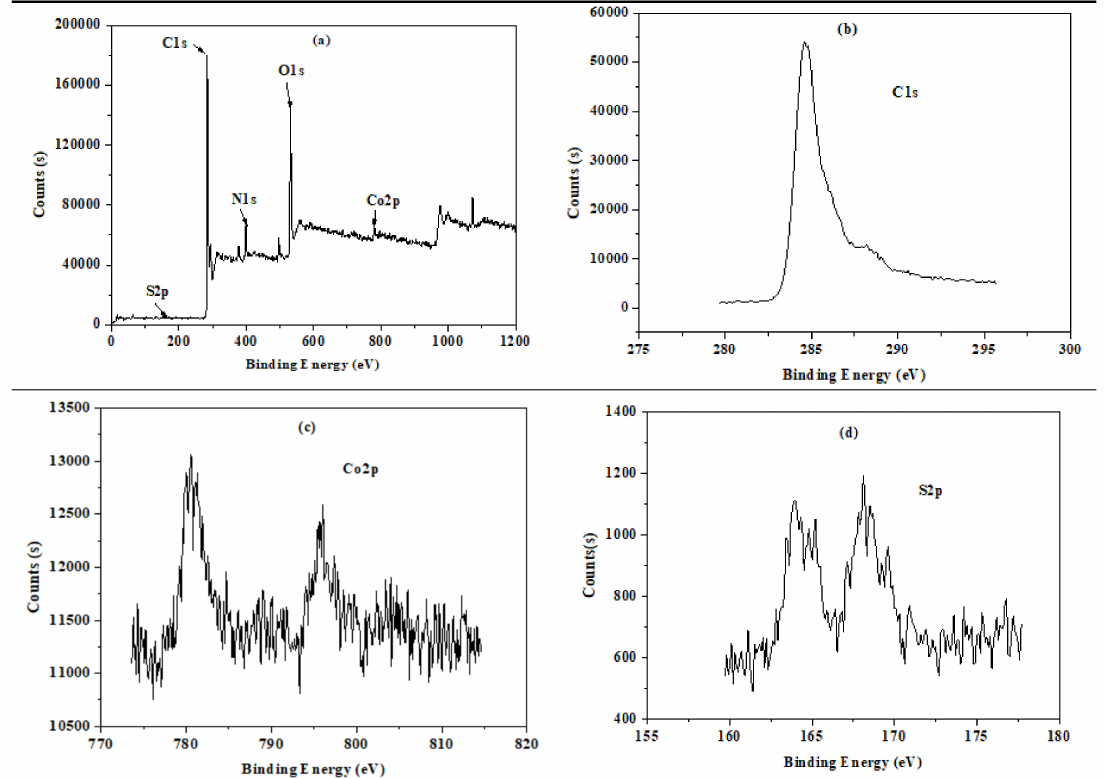
Figure 4. The XPS spectra of the AC-CoPcS ( a ), C1s ( b ), Co2p ( c ), and S2p ( d